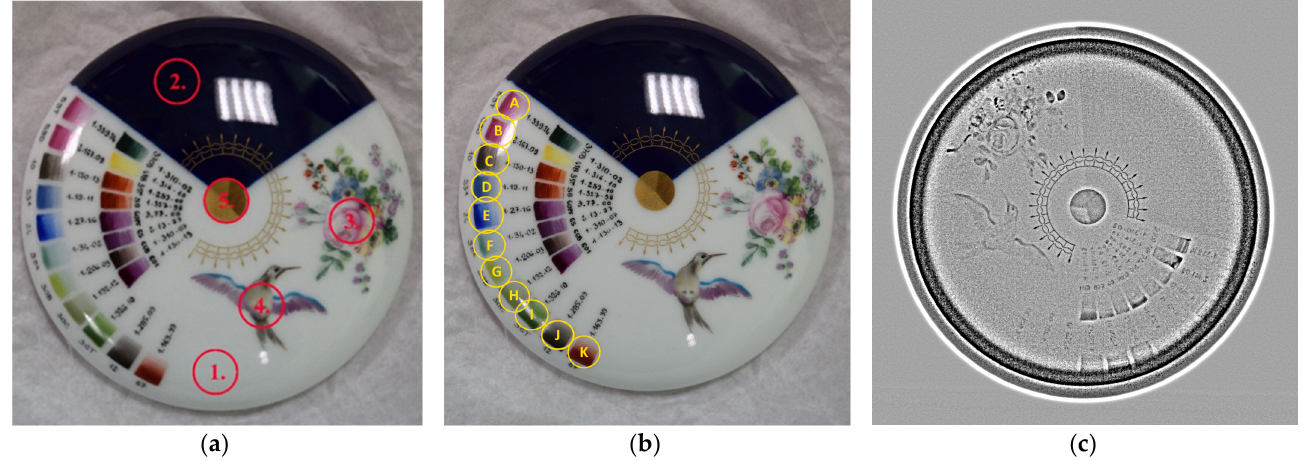
5 of 12 Figure 2. ( a ) the digital representation of the studied object obtained by 3D scanning, ( b ) the place- ment of the object in the MCNP6 simulation environment for PGAA matrix-effect correction, ( c ) the virtual model of the PGAI measurement geometry, visualizing the penetration of the pencil neutron beam, and ( d ) the elevation map for XRF scanning. 3. Results and Discussion The 3D scanned photorealistic digital model is provided in the Electronic Supple- mentary Materials. These scanned geometrical data served as input data to the measure- ment control and simulations, as described in Ref. [43] (Figure 2b,c). The measurement positions and dual-energy radiogram are visualized in Figure 3. Relevant parts of the